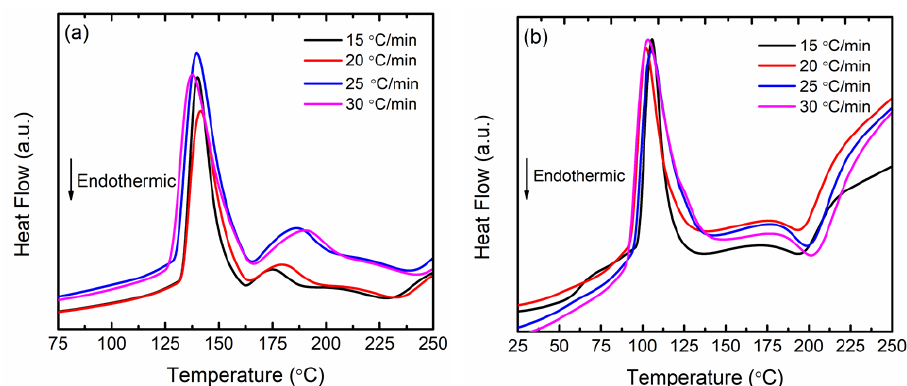
Figure 4. DSC profile of ( a ) as-milled LiAlH 4 and ( b ) LiAlH 4 + 10 wt.% CoTiO 3 at different heating rates.